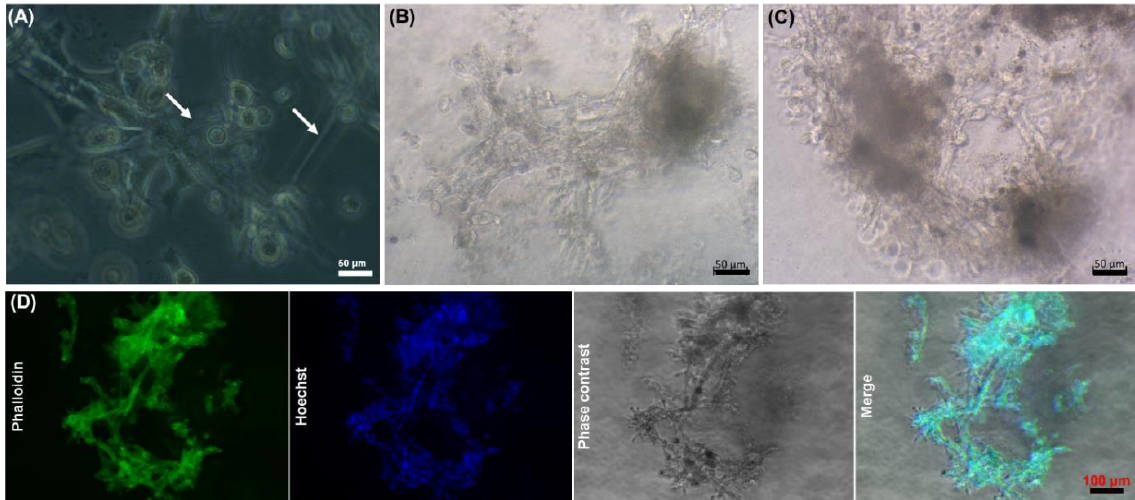
Figure 5. Formation of cellular structures within core-shell capsules in the course of long-term in vitro culture. Bright- field images of cellular formations on day 3 ( A ), day 17 ( B ) and day 35 ( C ). ( D ) Appearance of actin filaments (green fluorescence) and nuclei (blue fluorescence) evaluated using Phalloidin–Hoechst staining on day 17. White arrows in ( A ) show intercellular bridging and cell spreading. Scale bars are 50 µ m ( A – C ) and 100 µ m ( D